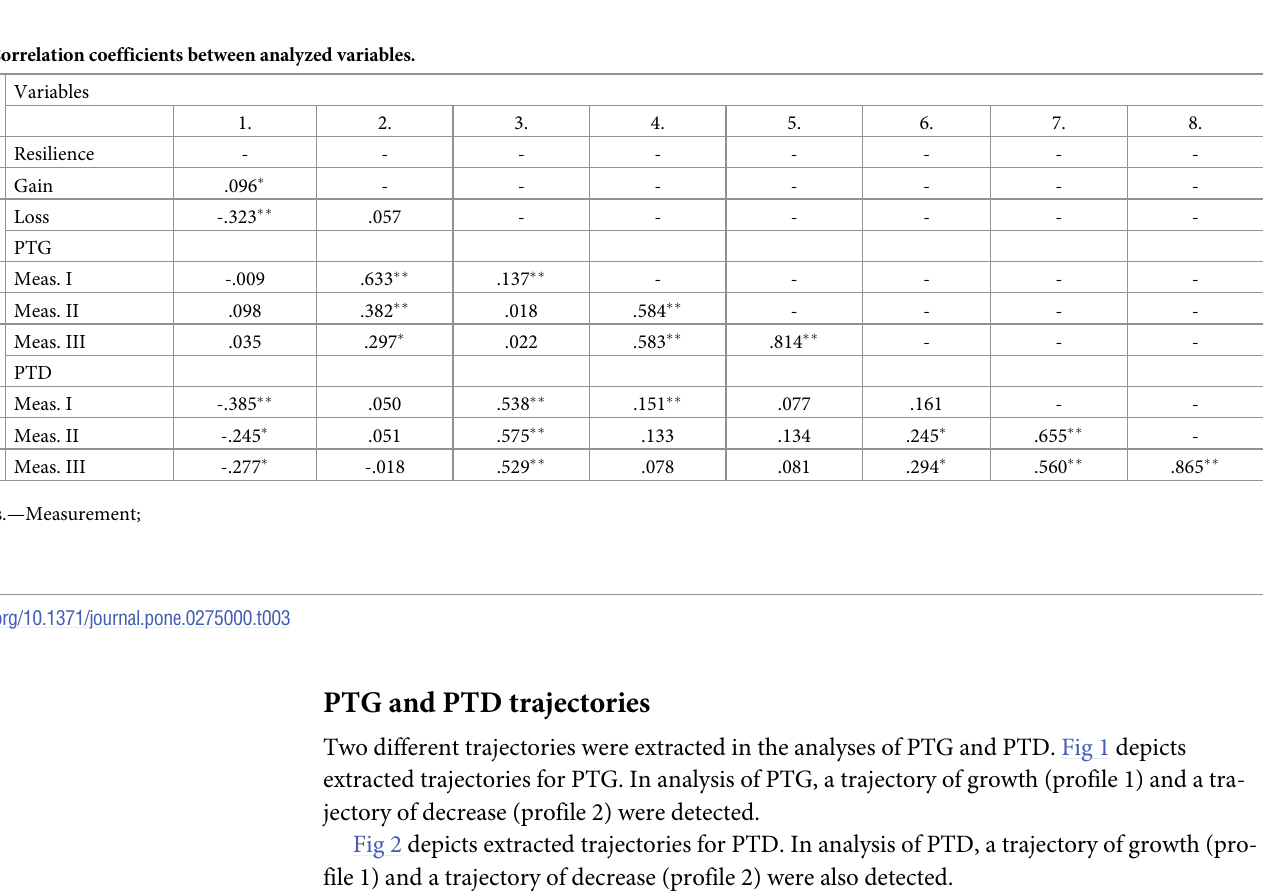
Two different trajectories were extracted in the analyses of PTG and PTD. Fig 1 depicts extracted trajectories for PTG. In analysis of PTG, a trajectory of growth (profile 1) and a tra- jectory of decrease (profile 2) were detected. Fig 2 depicts extracted trajectories for PTD. In analysis of PTD, a trajectory of growth (pro- file 1) and a trajectory of decrease (profile 2) were also detected.